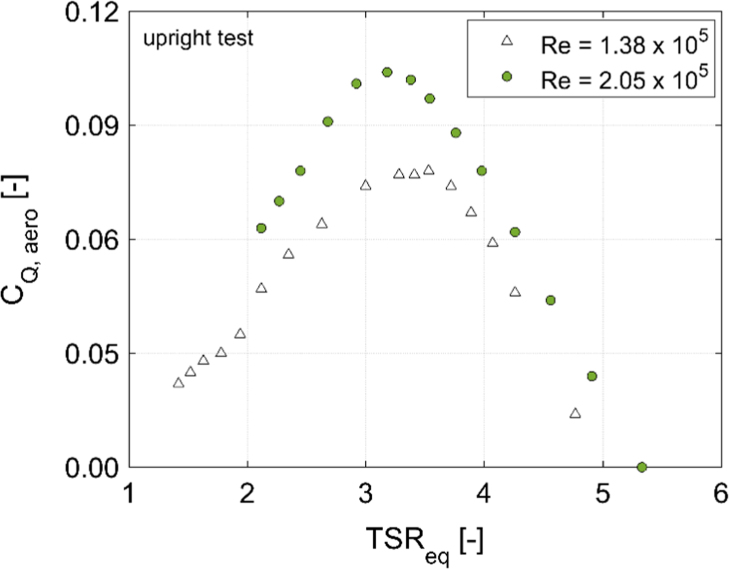
CQ curves for the upright rotor at 200 rpm (Re=1.38×105) and 300 rpm (Re=2.05×105).